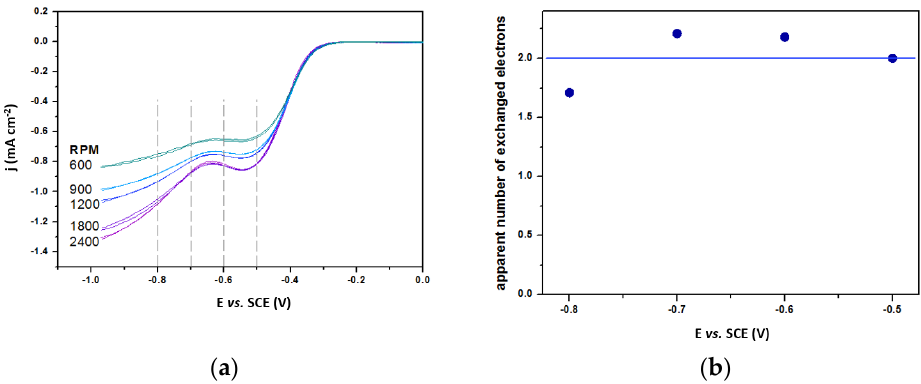
Figure 5. Background-corrected CVs for ORR in 0.1 M KOH at different rotation rates ( a ); depend- ence of the apparent number of exchanged electrons on the given potential, according to K–L anal- ysis ( b ).